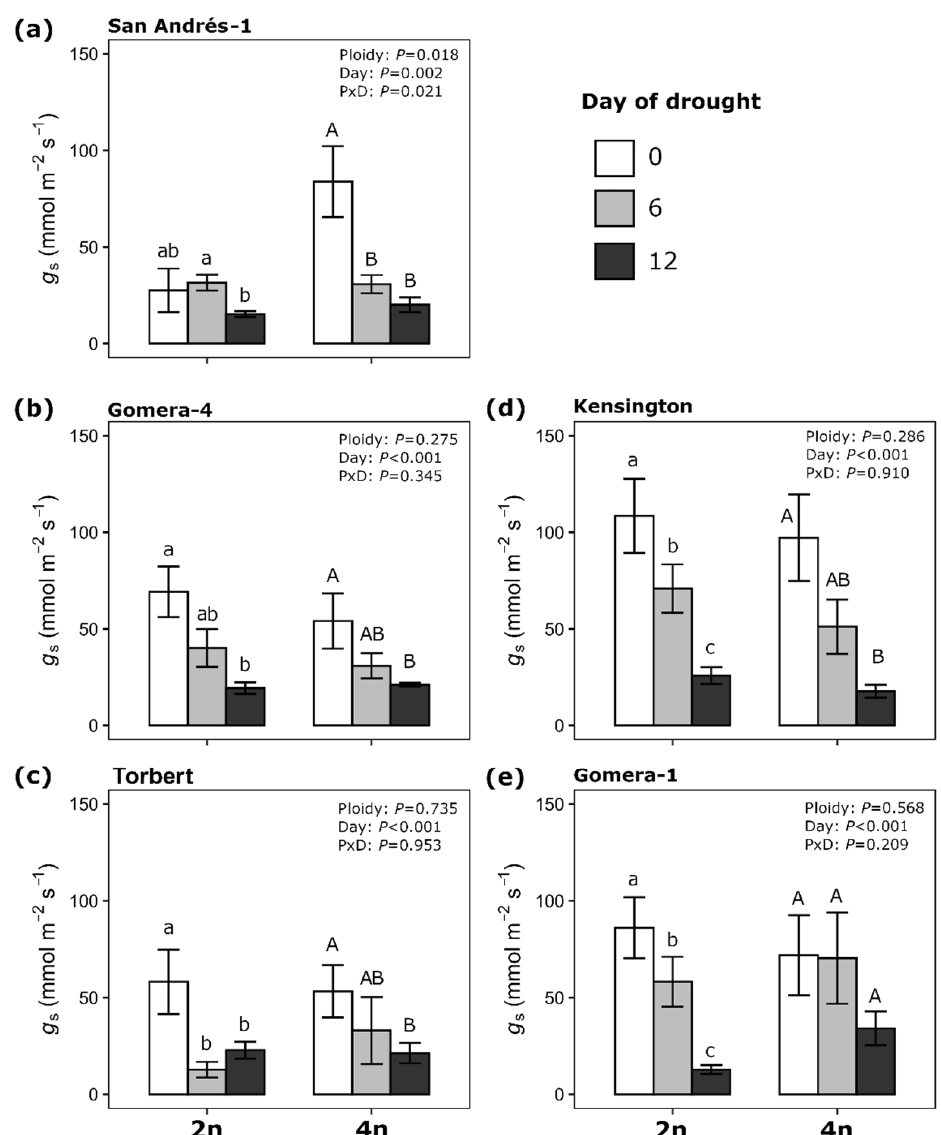
Figure 5. Variation of stomatal conductance to CO 2 ( g s ) on days 0, 6, and 12 of drought treatment (WS) application for the five studied cultivars: ( a ) ‘San Andrés-1’, ( b ) ‘Gomera-4’, ( c ) ‘Torbert’, ( d ) ‘Kensington Pride’, and ( e ) ‘Gomera-1’. Capital and lower-case letters mean significantly differences between g s values of tetraploid and diploids, respectively (Wilcoxon signed-rank tests, p < 0.05). The result of the mixed model is shown in the upper right corner of each panel. Values are means ± SE ( n =